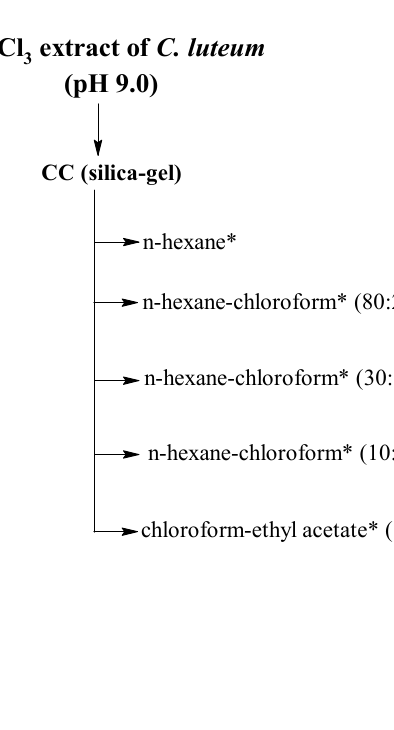
Molecules 2023 , 28 , x FOR PEER REVIEW 4 of 15 chloroform–ethyl acetate (85:15) 21.0 ± 0.5 CHCl extract of C. 3